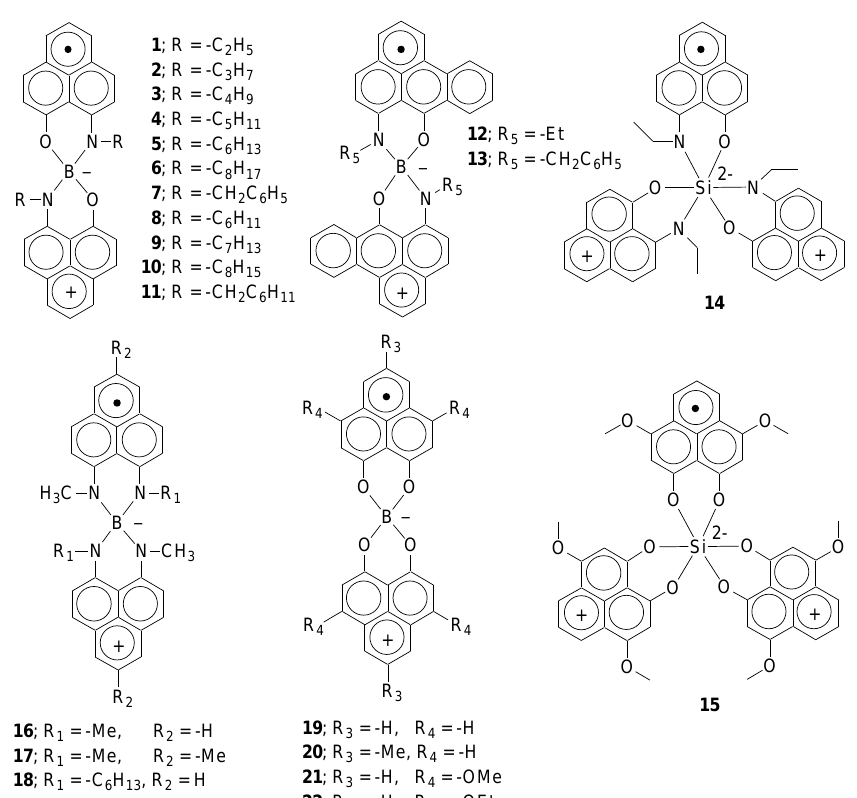
Scheme 1. Molecular structures of phenalenyl based